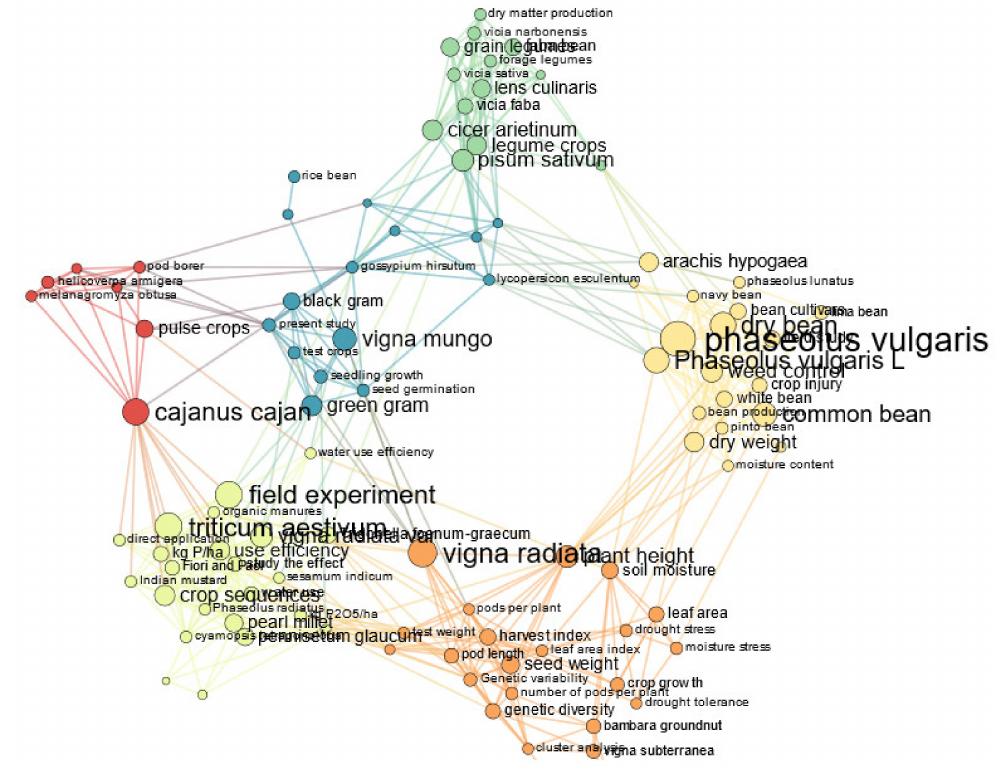
Figure 2. CorTexT Manager—script network mapping. The size of the dots reflects the occur- rence frequency: the larger the dot, the higher the occurrence. Analysis was performed on the 4082 documents identified in Scopus based on the 100 most recurrent